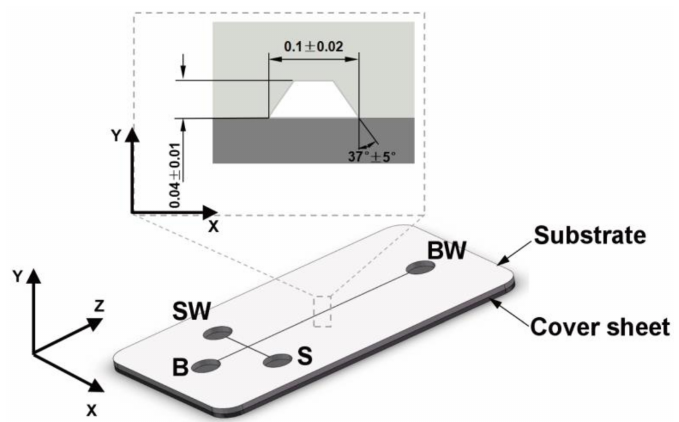
Figure 1. The structure of the microfluidic chip (Unit: mm). B, S, BW, and SW denote reservoirs containing bu ff er, sample, bu ff er waste, and sample waste, respectively.